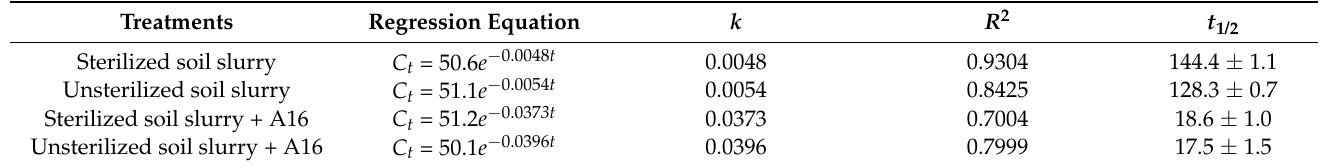
Table 3. Kinetic parameters of tetramethrin degradation with A16 in different soil slurries.